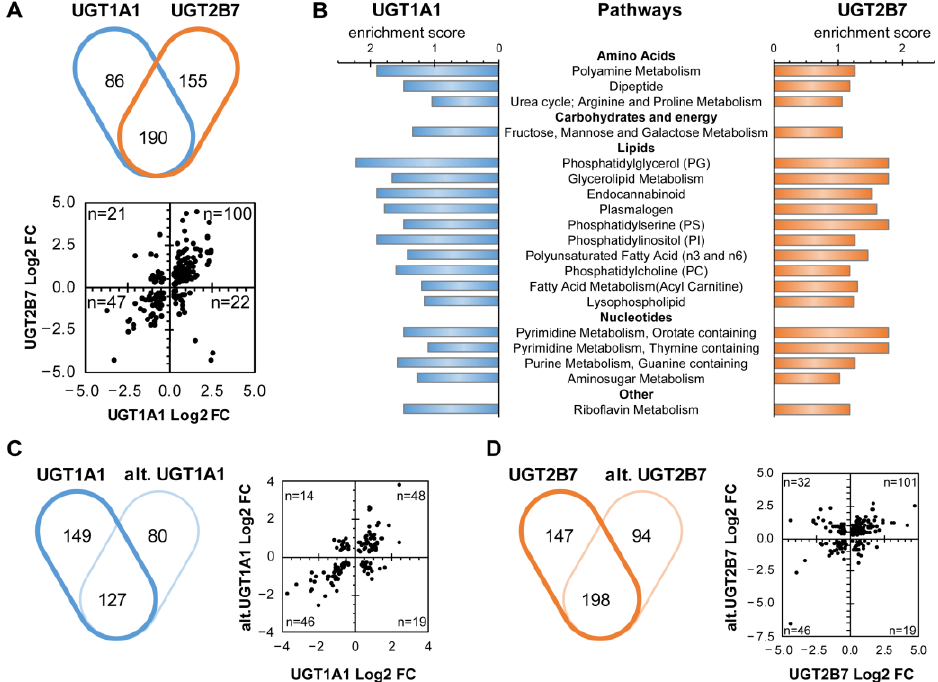
Figure 2. UGT expression induces significant perturbations of metabolite levels. Using an unbiased metabolomic approach, we showed that UGT expression modified intracellular metabolite concentrations in comparison to control cells. ( A ) Common and divergent changes in metabolite levels ( p < 0.05) for enzyme-expressing models are displayed in the Venn diagram (Upper panel), while the scatter plot (Lower panel) shows the log2 fold change (Log2 FC) of metabolites significantly altered in both cell models. Numbers of metabolites in each quadrant are displayed. ( B ) Pathway